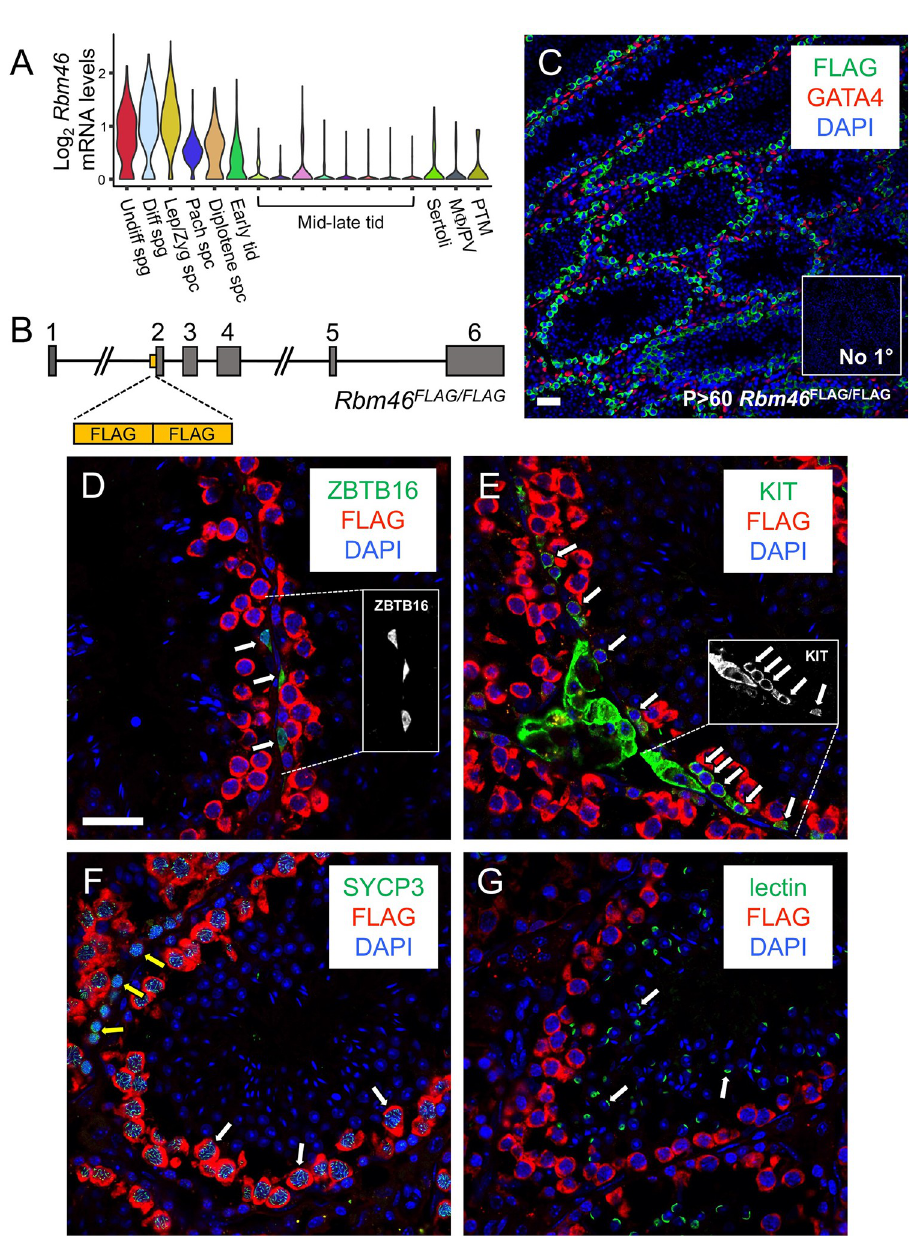
Fig 1. Rbm46 expression is restricted to spermatogonia, spermatocytes, and early round spermatids in the adult testis. ( A ) Violin plots showing relative mRNA levels from single cell (sc)RNA-seq data from adult mouse testes [4]. Undiff = undifferentiated; diff = differentiating; spg = spermatogonia; lep/zyg = leptotene + zygotene; pach = pachytene; spc = spermatocyte; tid = spermatid; M F = macrophage; PV = perivascular; PTM = peritubular myoid. ( B ) Diagram depicting insertion of the 2x FLAG tag upstream of exon 2 of the genomic Rbm46 locus. ( C-G ) IIF was performed to localize the RBM46-FLAG (green in C, red in D-G) in testes from adult Rbm46 FLAG/FLAG mice. ( C ) RBM46-FLAG (green) was detectable in germ cells but not in GATA4+ (red) Sertoli cells. ( D-G ) RBM46-FLAG (red) was faintly detectable in ZBTB16+ (green) undifferentiated spermatogonia and KIT+ (green) differentiating spermatogonia, indicated by white arrows. Insets in D-E are single fluorescent channel images of individual ZBTB16 + undifferentiated and chains of KIT+ differentiating spermatogonia (in white), respectively. RBM46-FLAG (red) became readily detectable in SYCP3+ (green) spermatocytes (white arrows = pachytene, yellow = leptotene) and was undetectable in lectin+ (green) spermatids (white arrows). Nuclei were stained with DAPI (blue). Scale bars = 25 μ m.